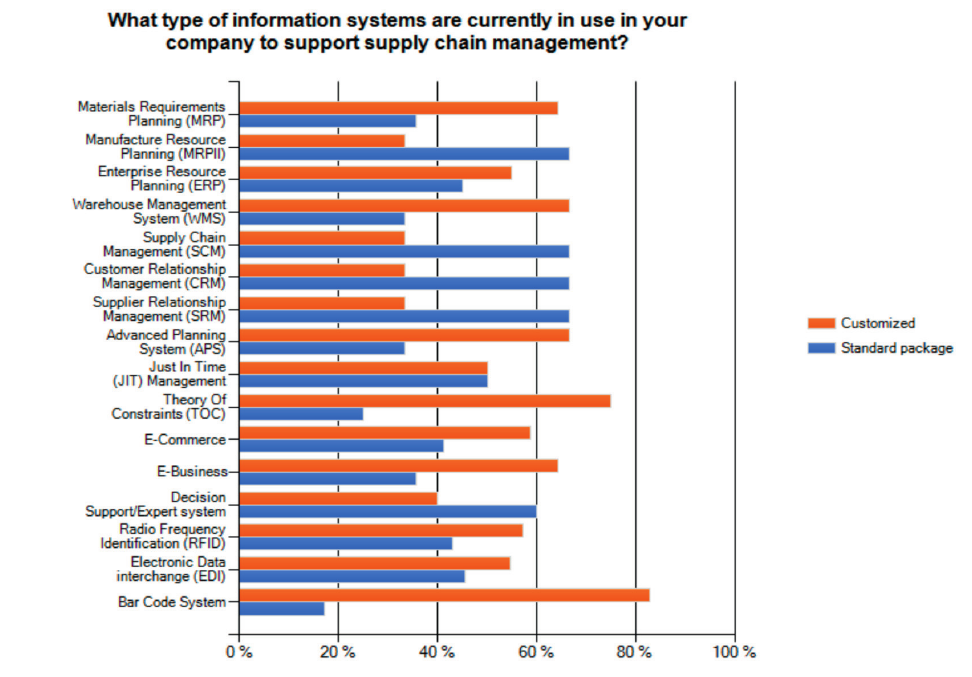
Figure 5: Type of AIS currently in